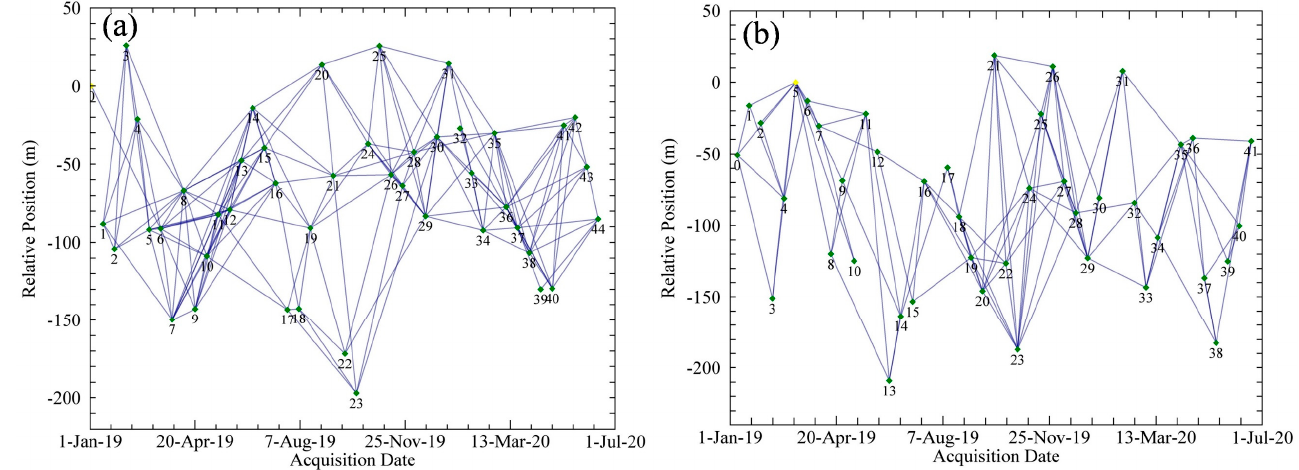
Figure 4. Spatiotemporal baseline map of SBAS-InSAR interferometric data of ascending track ( a ) and descending track ( b ).